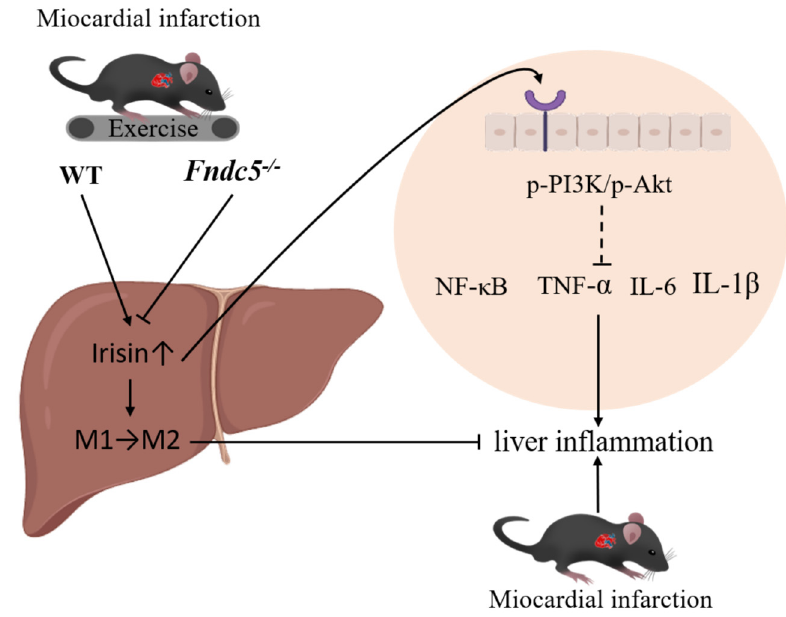
Figure 6. AE ameliorates MI-induced liver inflammatory injury.